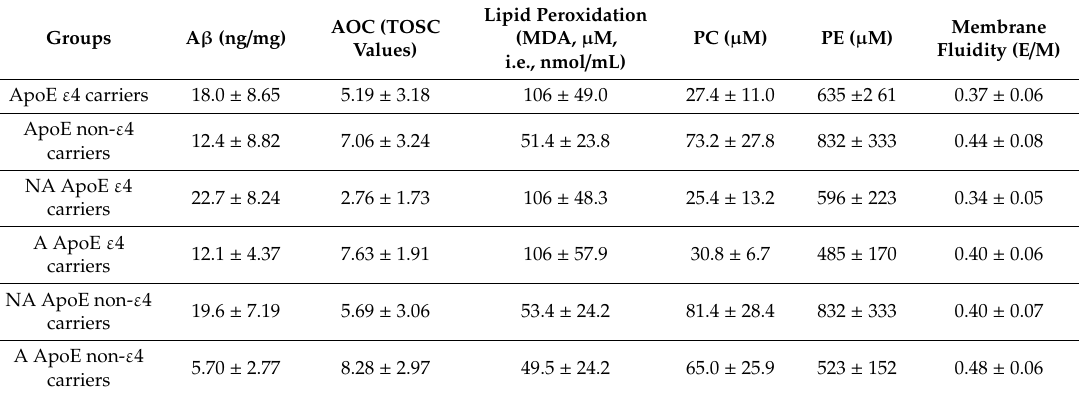
Table 2. Values of erythrocyte and plasma parameters analyzed in the